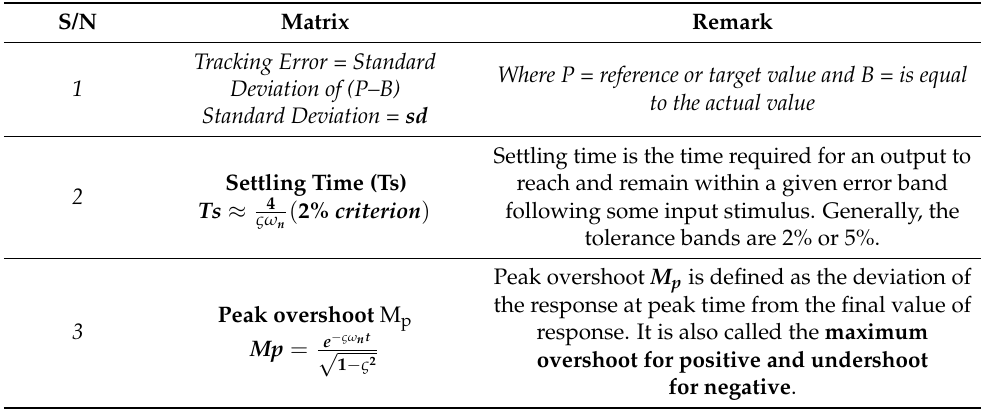
Table A2. Parameters of matrix of the evaluation of